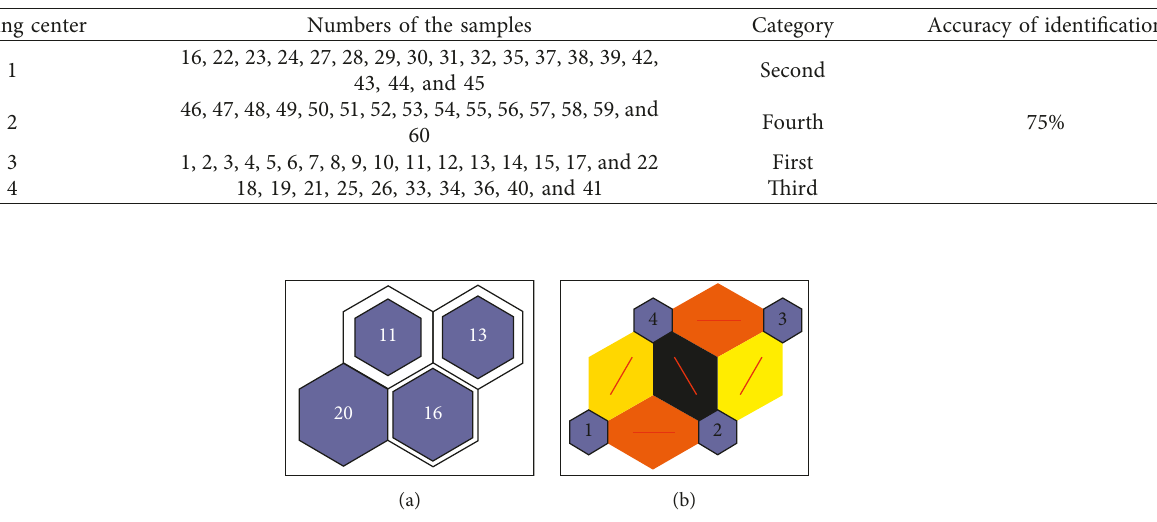
Table 2: The identification results.